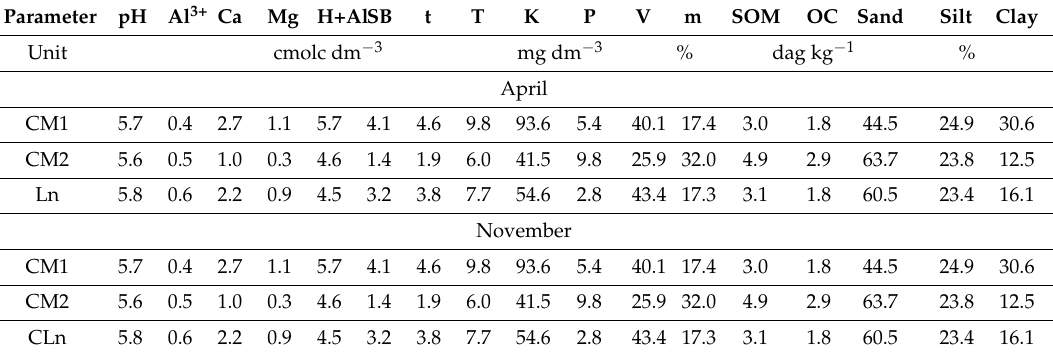
Table 2. Analytical results for the soil samples. The symbols were defined in the text (Section 2.3.1). Parameter pH Al 3+ Ca